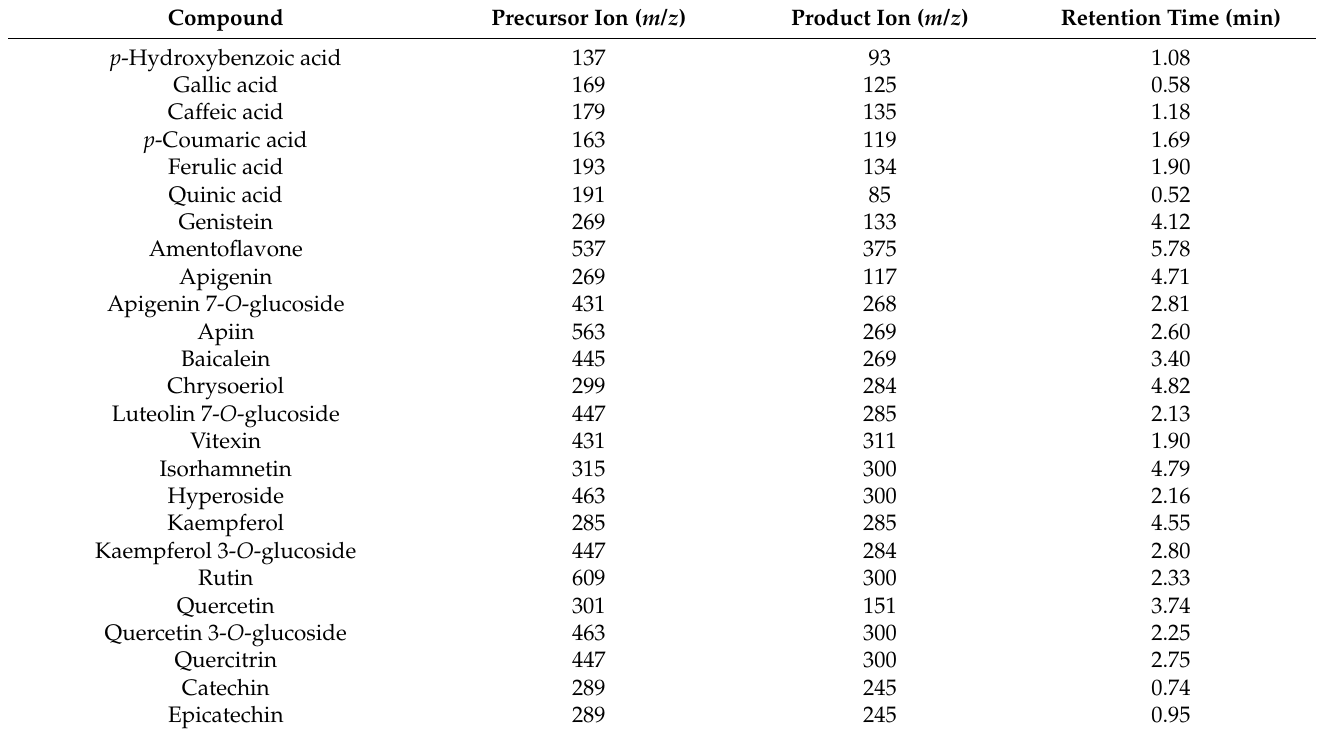
Table 5. Optimised HPLC-MS/MS dynamic MRM